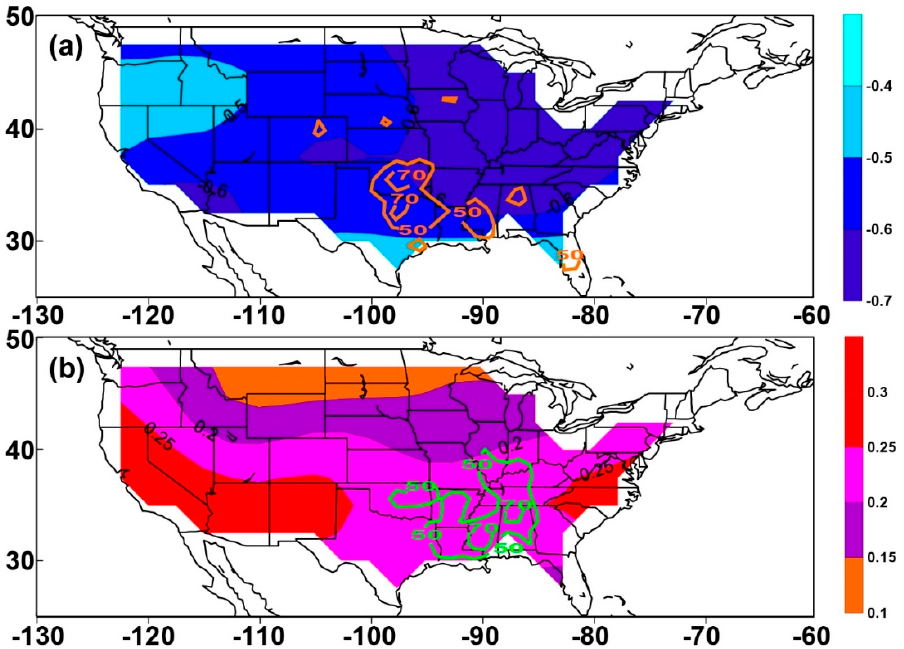
Figure 3. Composites of 500-hPa air temperature anomaly (°C) over time periods of ( a ) 1959 to 1988, and ( b ) 1989 to 2018. Tornado Alley is defined as the core area of (E)F1-(E)F5 tornado counts of 50 or more per 1° × 1° grid box over a 30-year period with orange color in ( a ) and green color in ( b ).